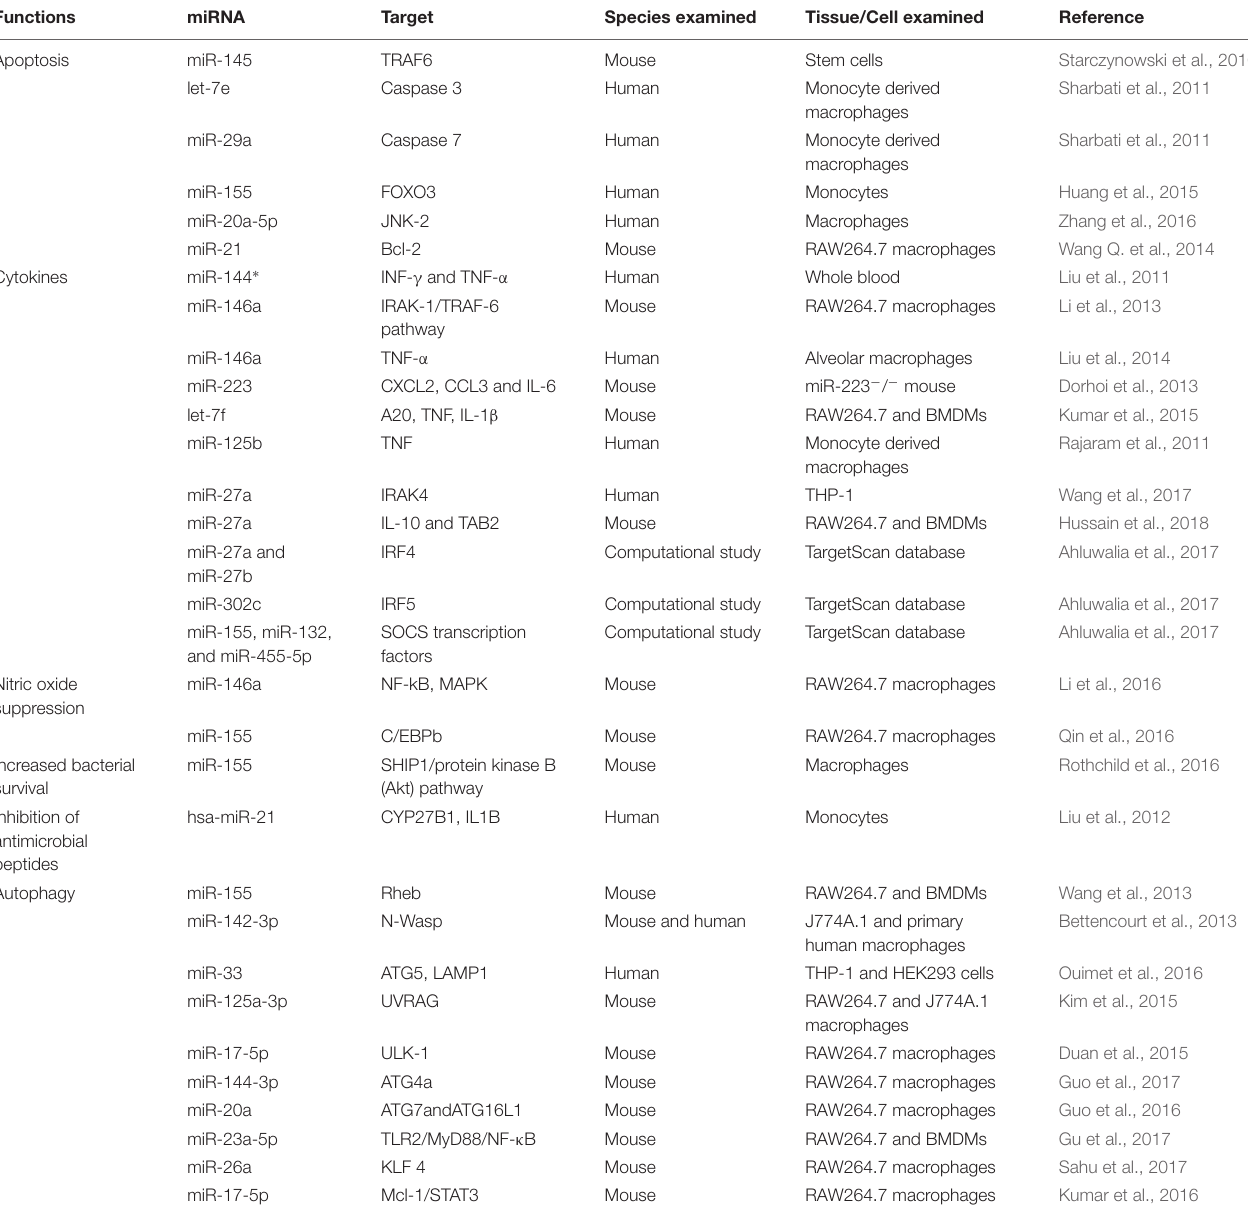
TABLE 2 | miRNAs regulation of host immune response in